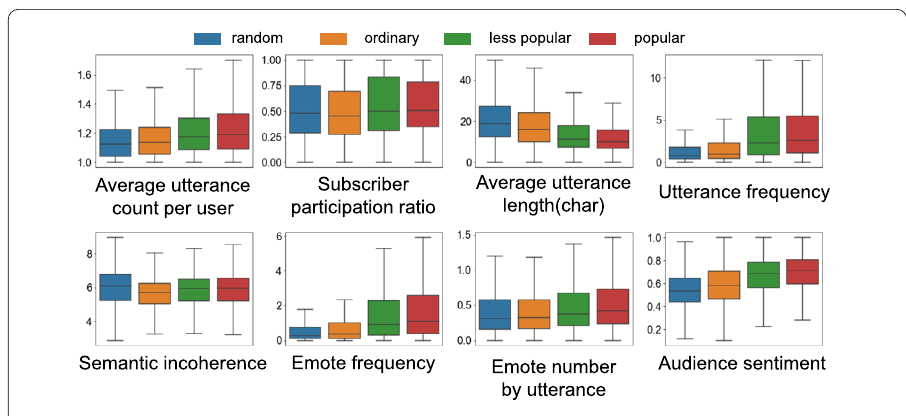
Figure 3 Boxplot of feature difference over the view count groups